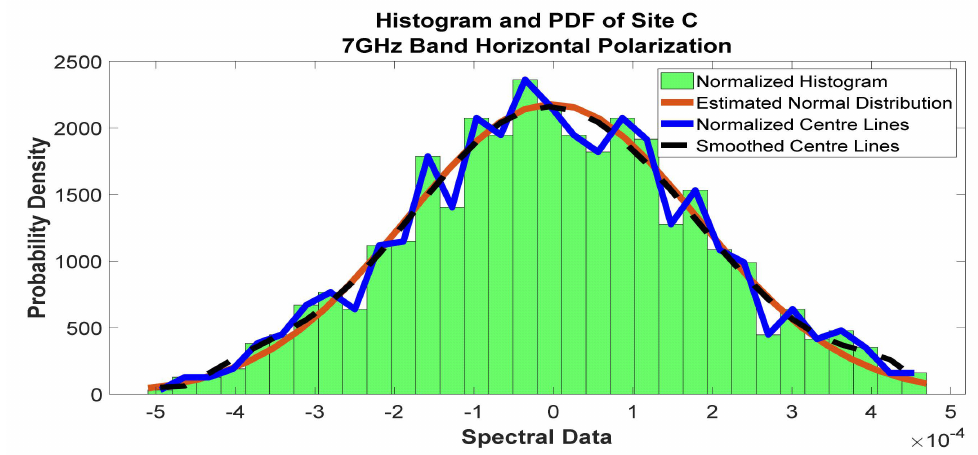
Figure 21. Histogram and PDF of the frequency scan for site C at 7 GHz horizontal